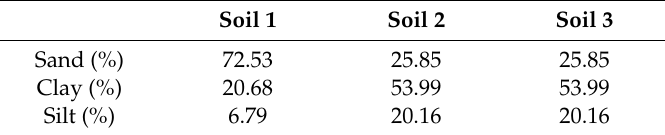
Table 1. The composition of experimental